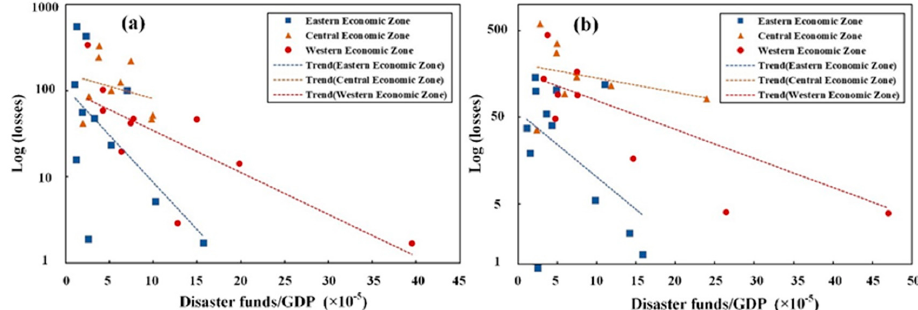
Figure 8. Relationships between direct economic losses from natural disasters and disaster funds in 2019 and 2020. ( a ) Relationships between direct economic losses from natural disasters and disaster funds obtained in 2019 (Eastern Economic Zone: R 2 = 0.1833, Central Economic Zone: R 2 = 0.0465, Western Economic Zone: R 2 = 0.4783); ( b ) Relationships between direct economic losses from natural disasters and disaster funds obtained in 2020 (Eastern Economic Zone: R 2 = 0.0524, Central Economic Zone: R 2 = 0.1834, Western Economic Zone: R 2 = 0.2099).